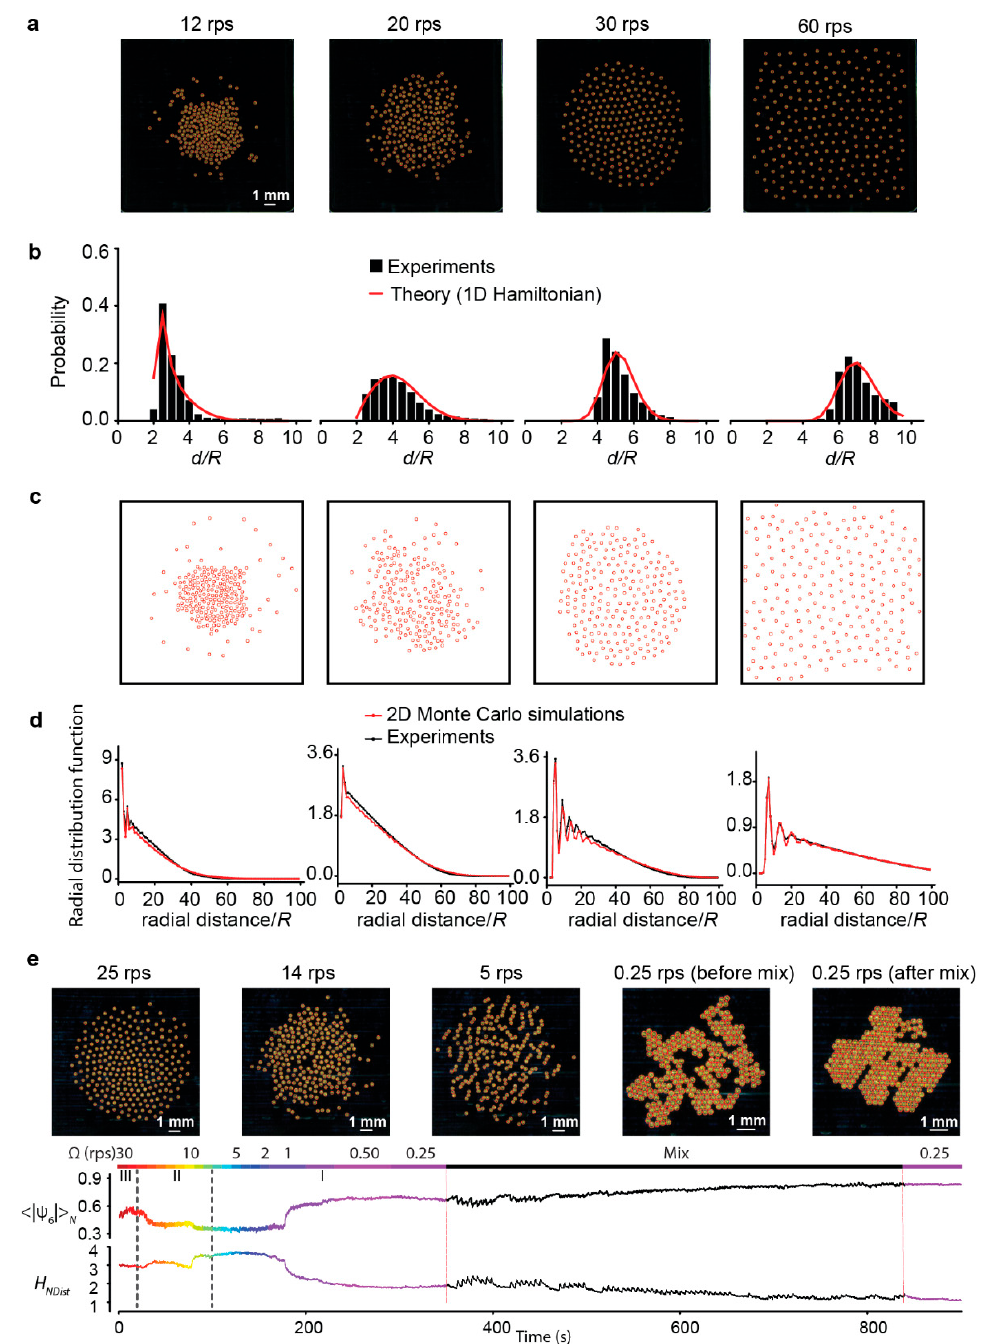
Figure 5. Order and information of a driven self-organizing system consisting of spinning micro- disks at the air-water interface. ( a ) Representative patterns at four different spin speeds. ( b ) The corresponding probability distribution of neighbor distances. The theoretical curves were calculated from an effective Hamiltonian based on mean-field theory. ( c ) 2D Monte Carlo simulation of the patterns based on the information of the neighbor distance distributions in ( b ). ( d ) The radial distribution functions of both experimental patterns and the patterns obtained from the Monte Carlo simulations. ( e ) Tiling experiment that demonstrates the close relation between order, represented by hexagonal order parameter ψ 6 , and information, represented by the Shannon entropy by neighbor distance H NDist (adapted from